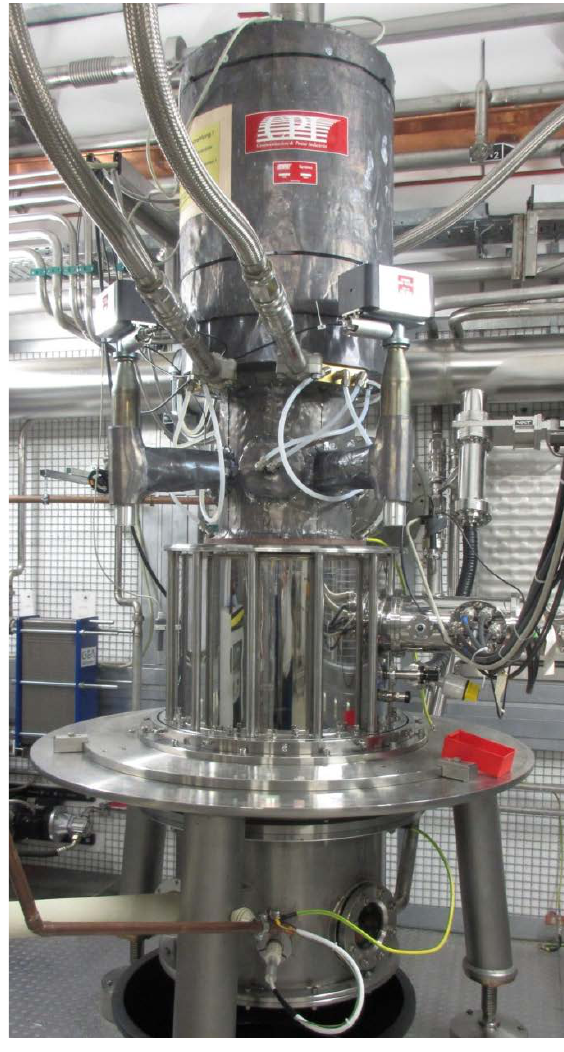
Fig. 1. The VGT-8141A gyrotron, installed at the customer site